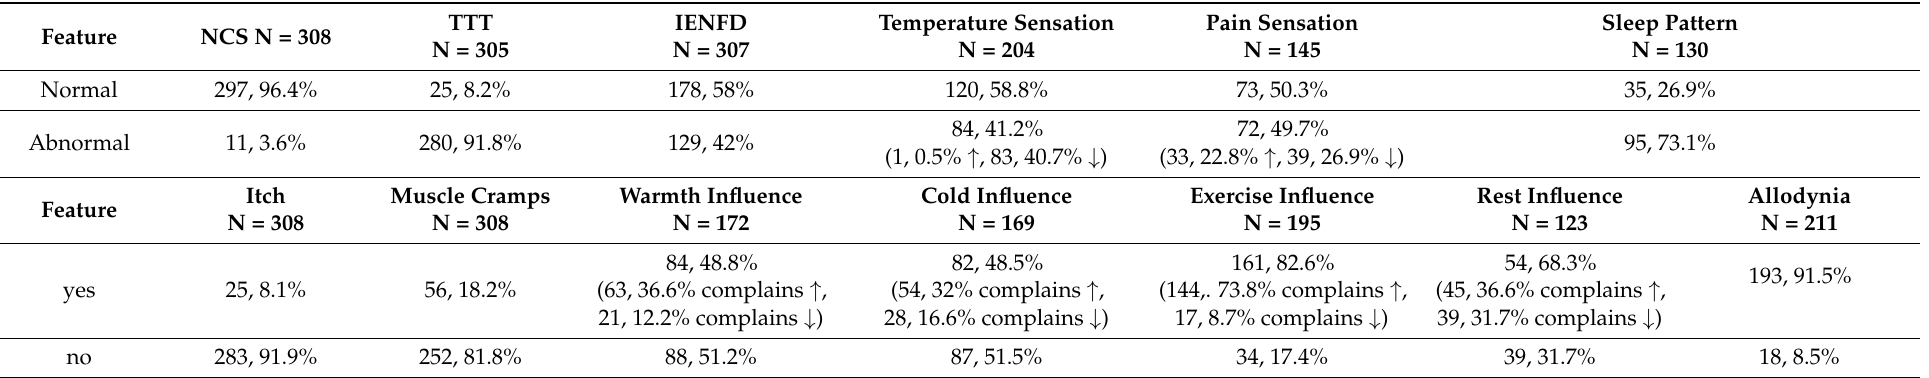
Table 5. Clinical features of SFN patients without an ICG/VGSC